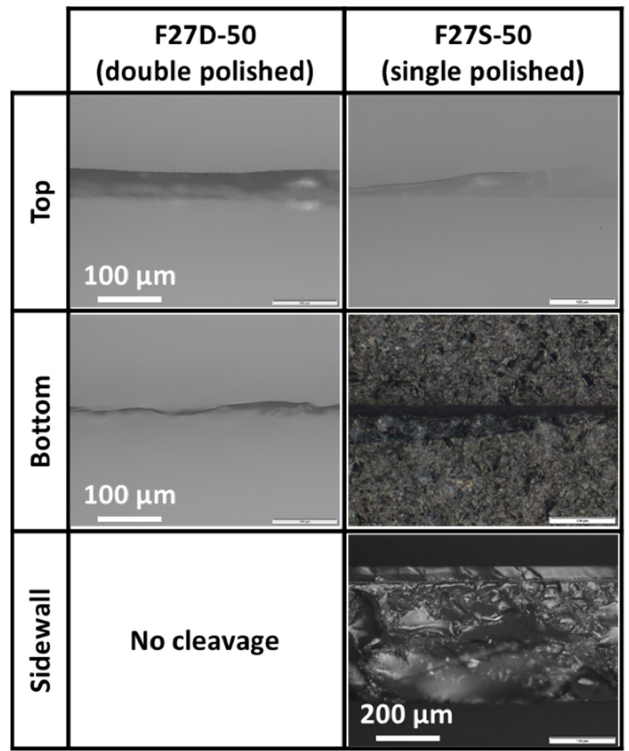
Figure 4. Optical images of samples’ surfaces and sidewall profiles at 0.1 mm/s scanning speed for Experiments F27D-50 and F27S-50 (i.e., after full-section irradiation with 27 foci and a 7.5 mm EFL at a pulse repetition rate of 50 kHz at 1.13 W).